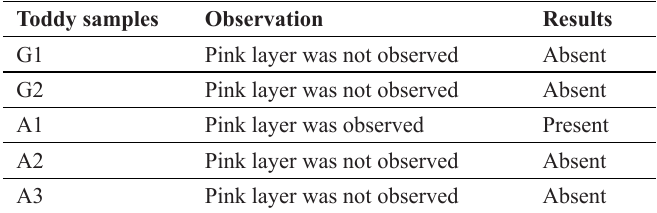
Table 2: Test results for the presence of chloral hydrate in toddy samples